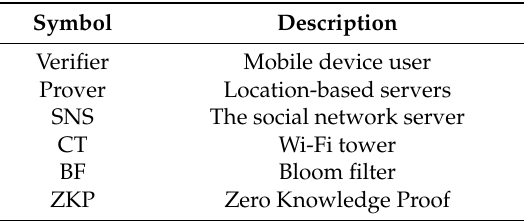
Table 1. System architecture.